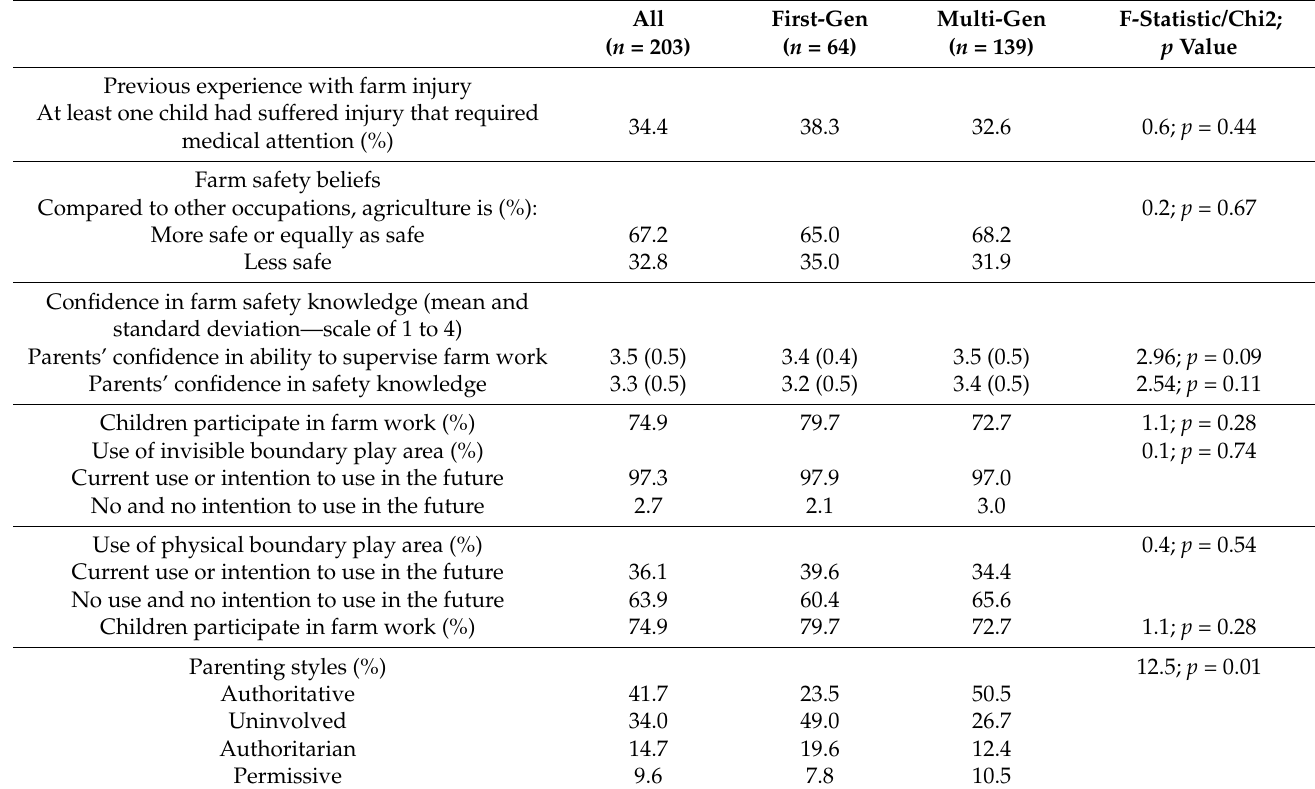
Table 4. Comparison of children safety measures across first- and multi-generational